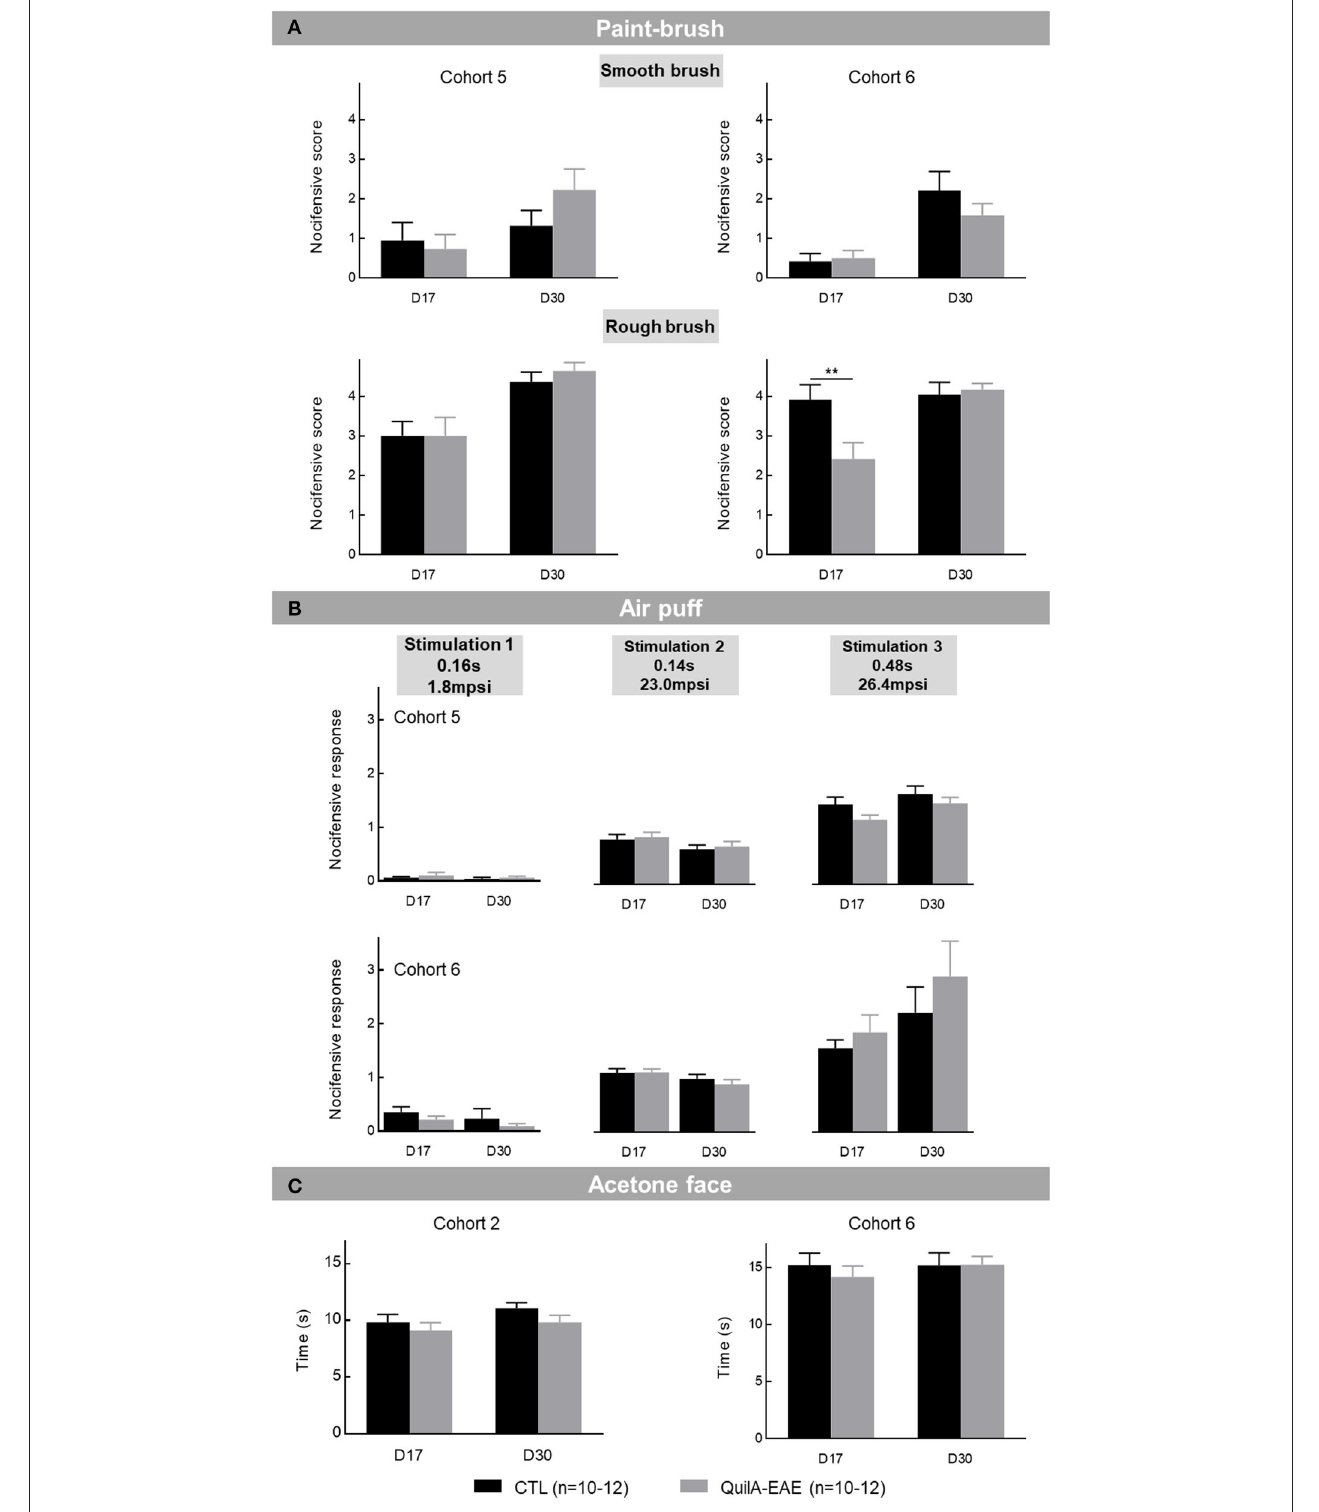
FIGURE 4 | Evaluation of orofacial sensitivity in mice immunized with MOG 35 − 55 (QuilA-EAE) and their controls (CTL) at post-induction Day 17 (D17) and D30. (A) Mechanical dynamic sensitivity to smooth and rough paintbrushes. Mechanical dynamic sensitivity expressed as the mean number of positive responses ±